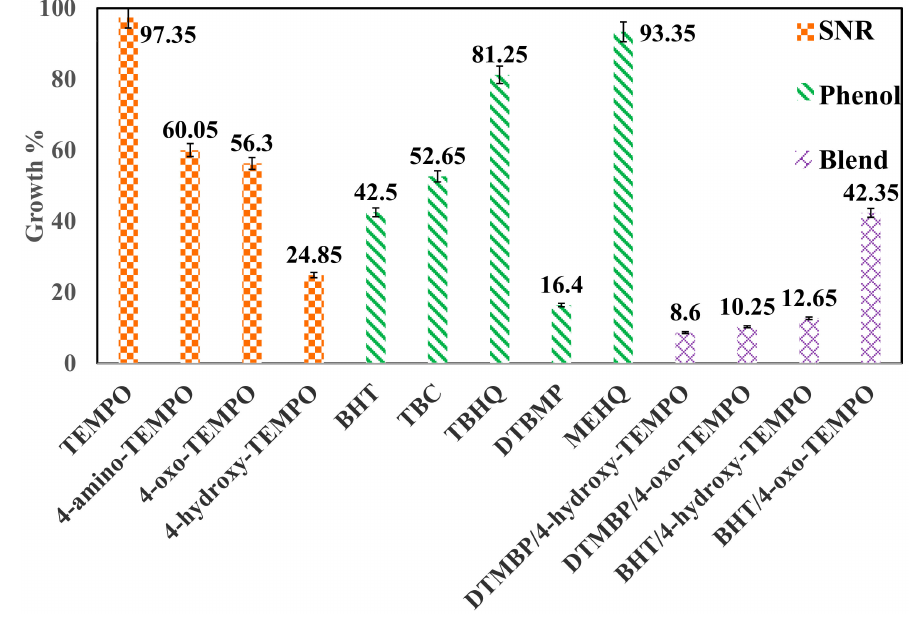
Figure 11. Growth percentage of SNRs, phenolics, and